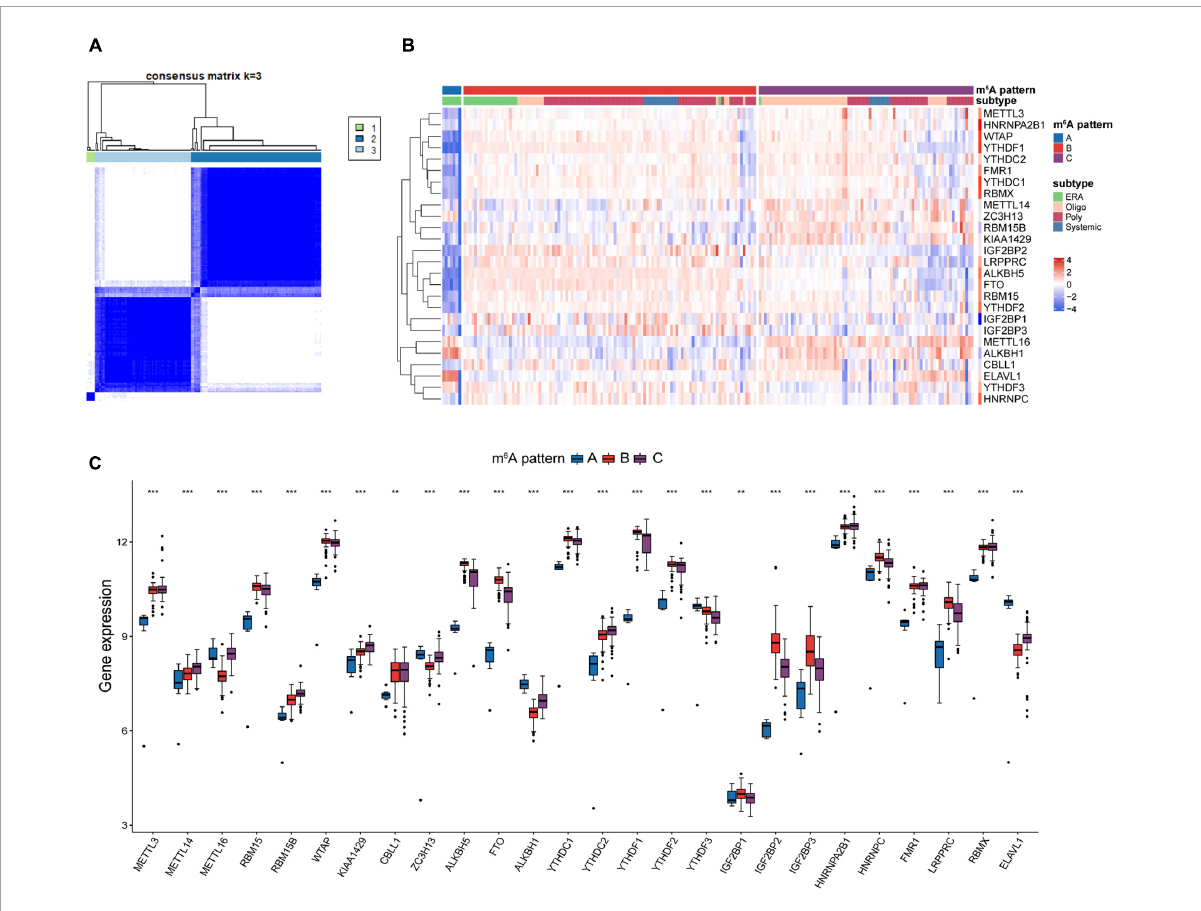
FIGURE3 Unsupervised clustering analysis of 26 m 6 A regulators. (A) Consensus clustering classified juvenile idiopathic arthritis (JIA) into three m 6 A patterns. (B) Differences between the m 6 A patterns and extant classification system. (C) Different expressions of the m 6 A regulators in the three m 6 A